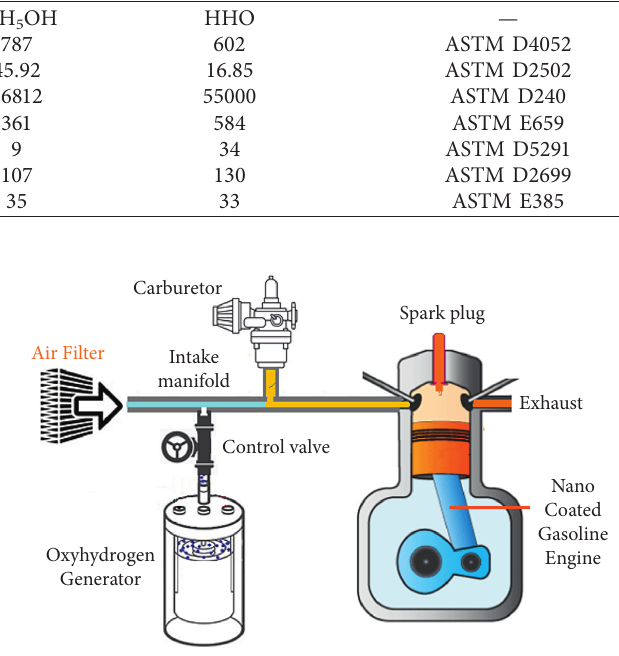
Figure 1: Schematic arrangement diagram of the gasoline engine experimental